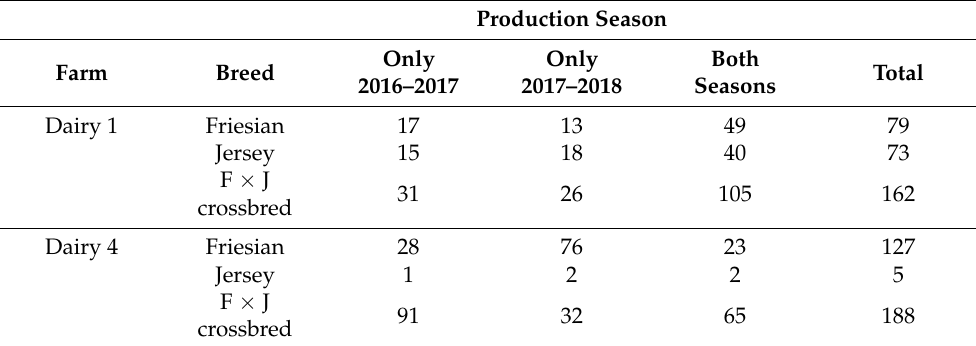
Table 1. Cows from each farm, breed group and production season used for the genome-wise association